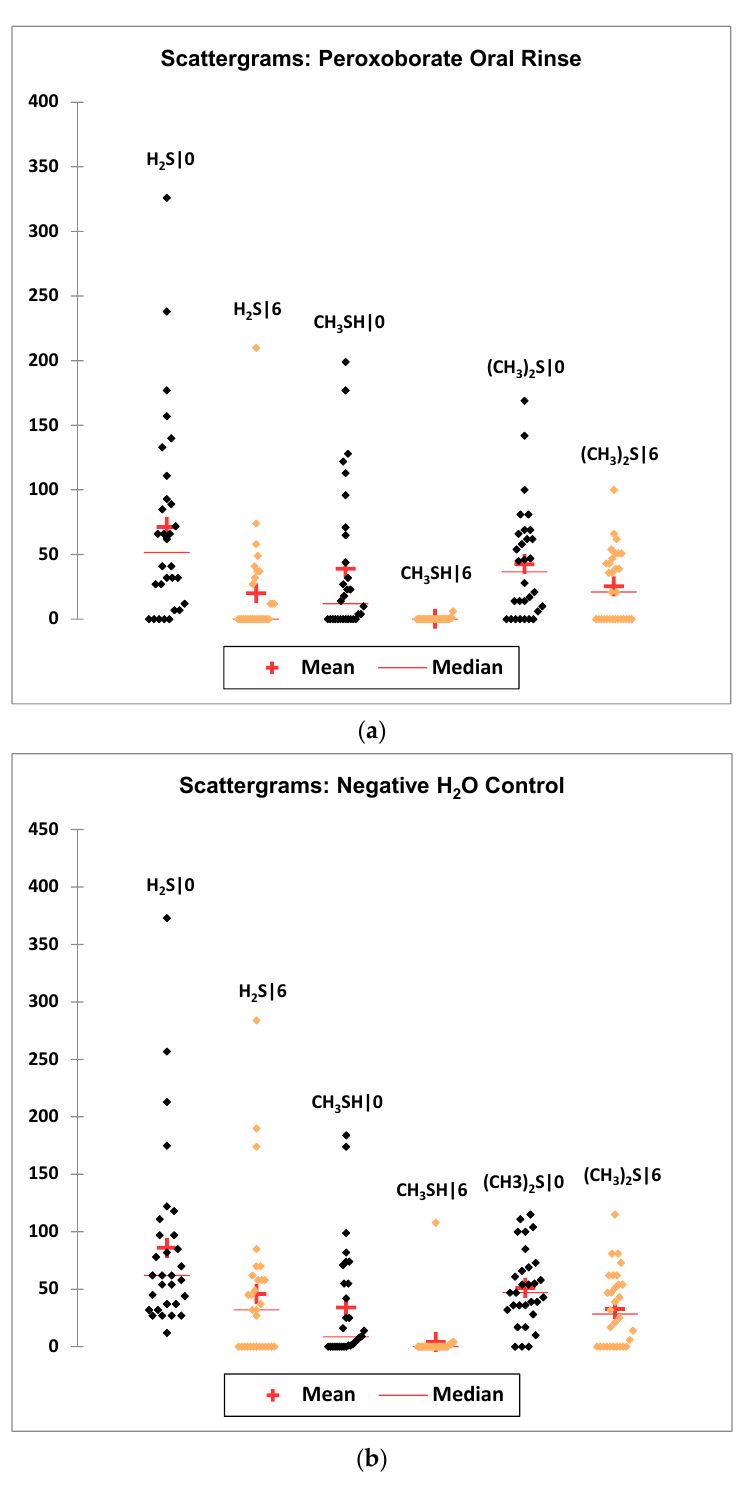
Figure 5. Scattergrams of oral cavity H 2 S, CH 3 SH and (CH 3 ) 2 S level datasets at the 0.00 and 6.00 h. time-points for ( a ) the peroxoborate oral rinse treatment regimen, and ( b ) the negative water control groups. Mean and median values for these groups are provided. Abbreviations: H 2 S|0 and H 2 S|6, H 2 S concentrations (ppb) at the 0.00 and 6.00 h. time-points respectively, with the same abbreviations for CH 3 SH (CH 3 SH|0 and CH 3 SH|6) and (CH 3 ) 2 S ((CH 3 ) 2 S|0 and (CH 3 ) 2 S|6).